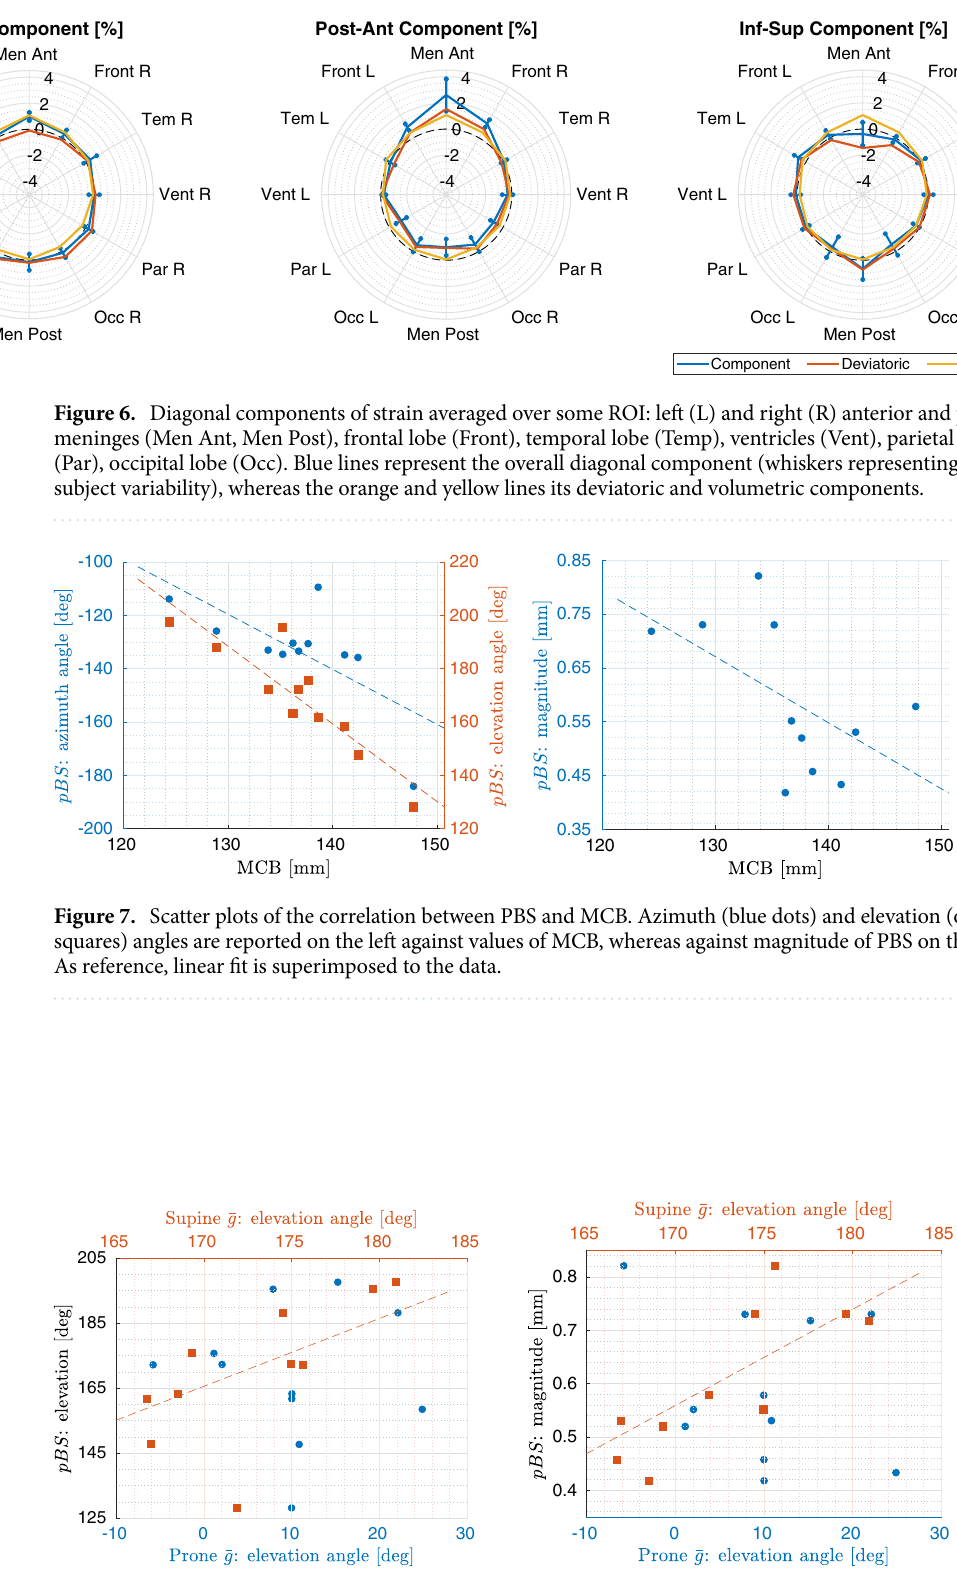
Figure 8. Scatter plots of the correlation between PBS and gravity ( ¯ g ). Elevation angle of gravity is here reported against elevation angle (left) and against magnitude of PBS (right) for both prone (blue dots) and supine (orange squares) positioning. As reference, linear fit is superimposed to the data in the case of the statistical correlation between elevation angle of ¯ g in supine and both elevation angle (on the left) and magnitude (on the right) of